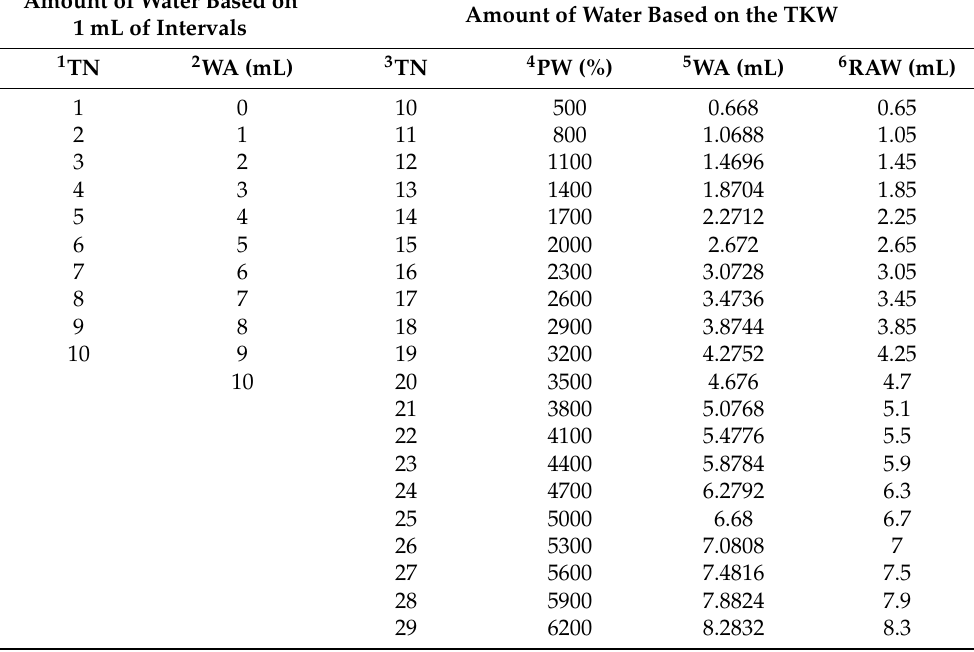
Table 4. Water amount levels based on one-milliliter intervals and TKW%. Amount of Water Based on 1 mL of